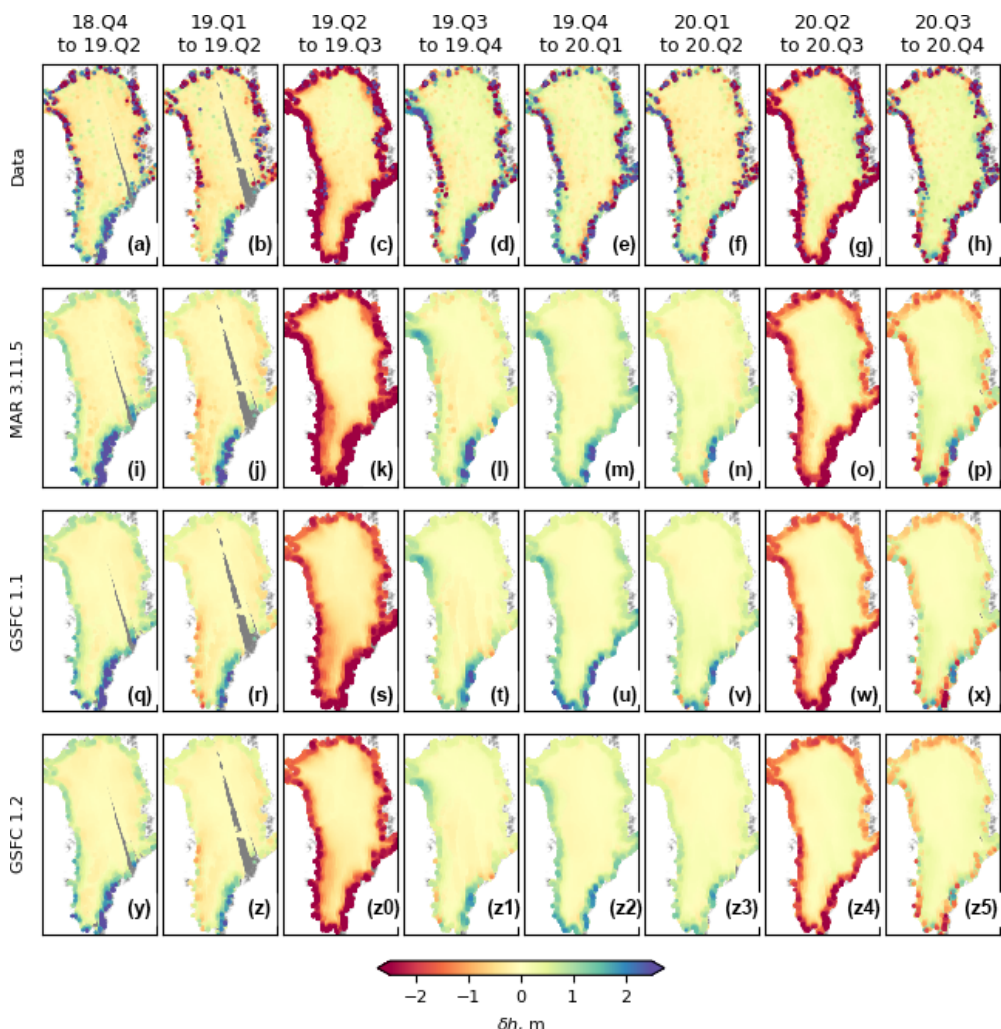
Figure 3. Measured height differences in Greenland from ATL11 (a–h) and the predicted height changes from MAR3.11.5 (i–p) , from GSFCv1.1 (q–x) , and from GSFCv1.2 (y–z5) . Points on the plots show the measured or predicted height differences for each epoch (listed at top) and are masked to include only on-ice points but are not masked based on velocity